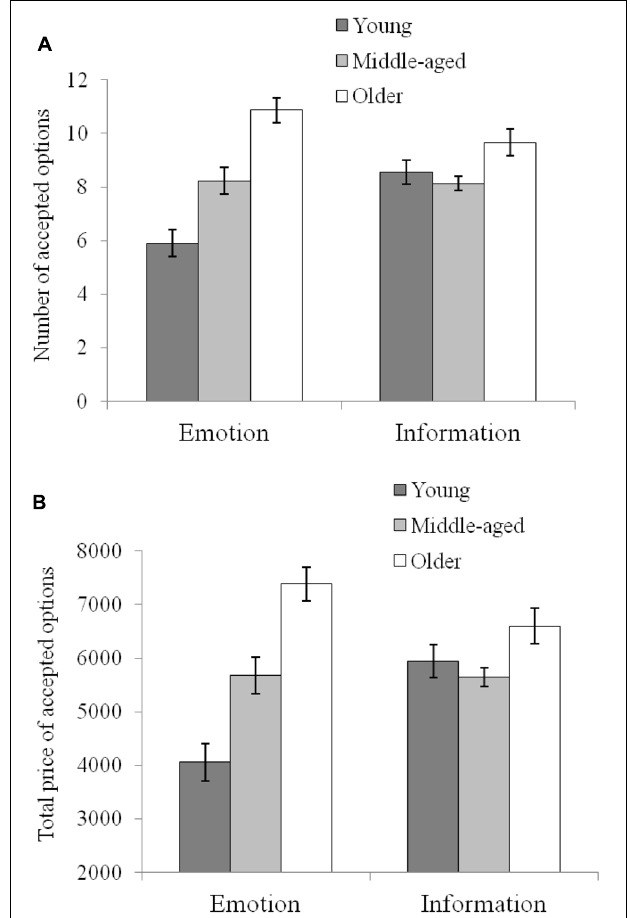
FIGURE 2 | (A) Displays the number of accepted options for each age group across the different focus conditions. (B) Displays the total price of accepted options for each age group across the different focus